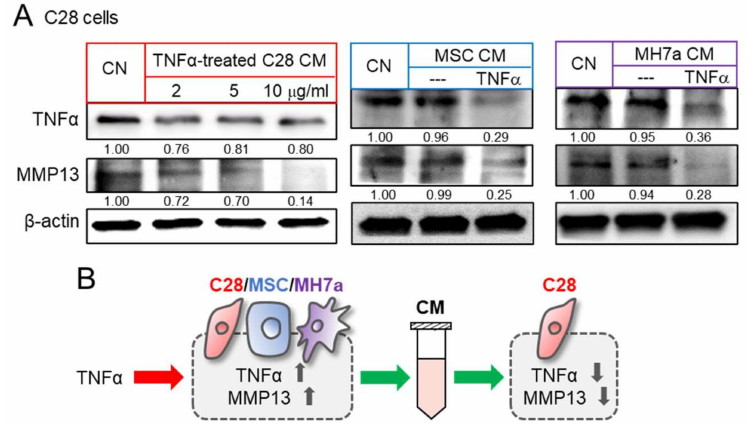
Figure 3. Reduction in TNF α and MMP13 in C28 chondrocytes by TNF α -treated CM. CN = control, C28 = C28/I2 chondrocytes, and MH7a = MH7a synovial cells. ( A ) Downregulation of TNF α and MMP13 in C28/I2 chondrocytes by TNF α -treated CS cell, MSC, and C28 chondrocyte-derived CMs, respectively. MSCs and MH7a cells were treated with 10 ng/mL of TNF α . ( B ) Schematic diagram for the effects of TNF α and TNF α treated cells-derived CM. Full Western blot images are available in Figure S8.